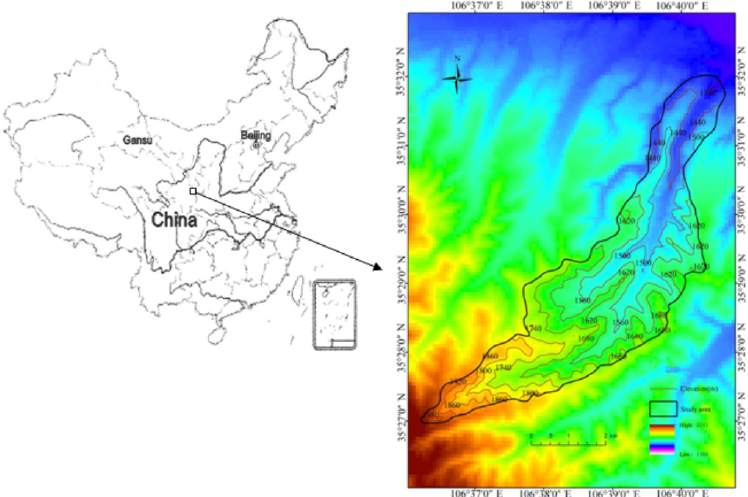
Figure 1. The topography of Zhifanggou